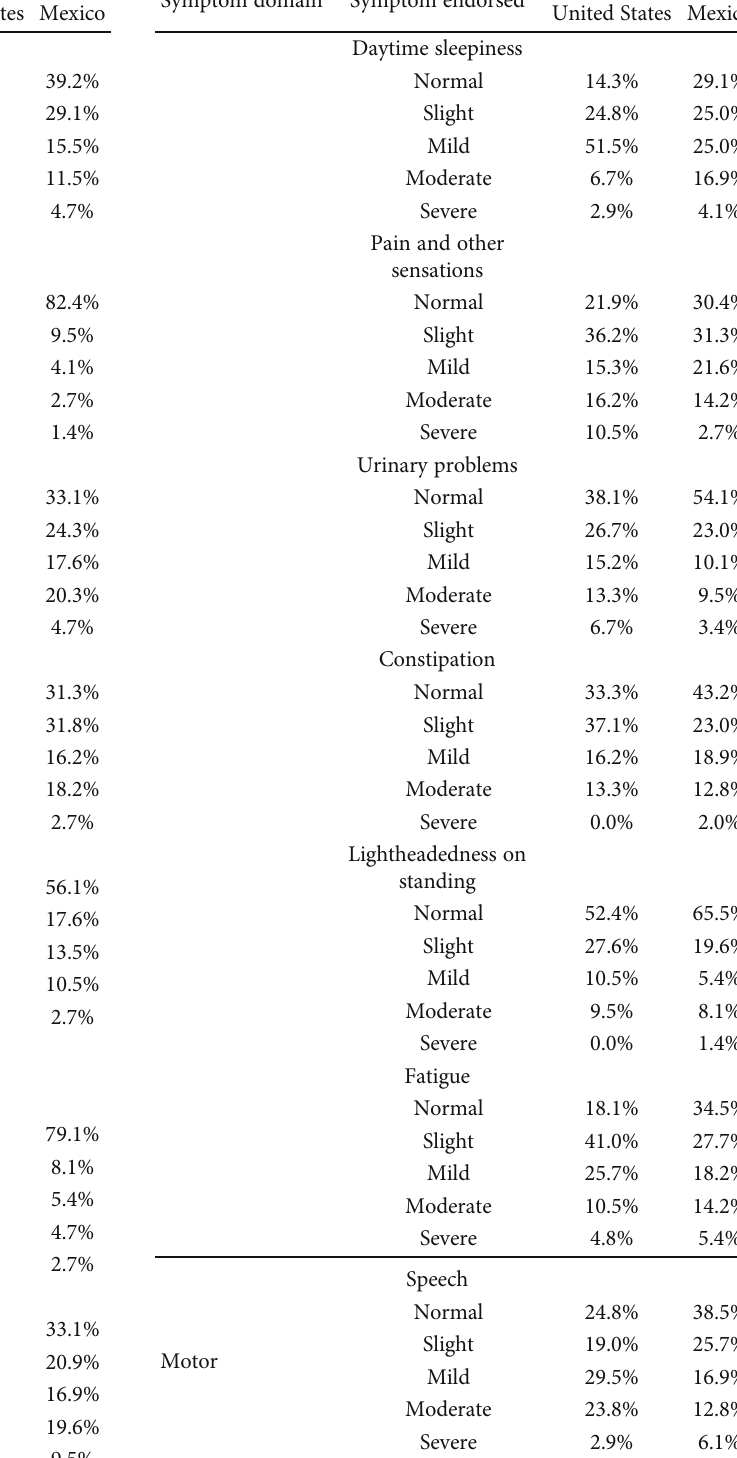
Table 2: Summary of symptoms reported by caregivers ( N = 253 ). Table 2: